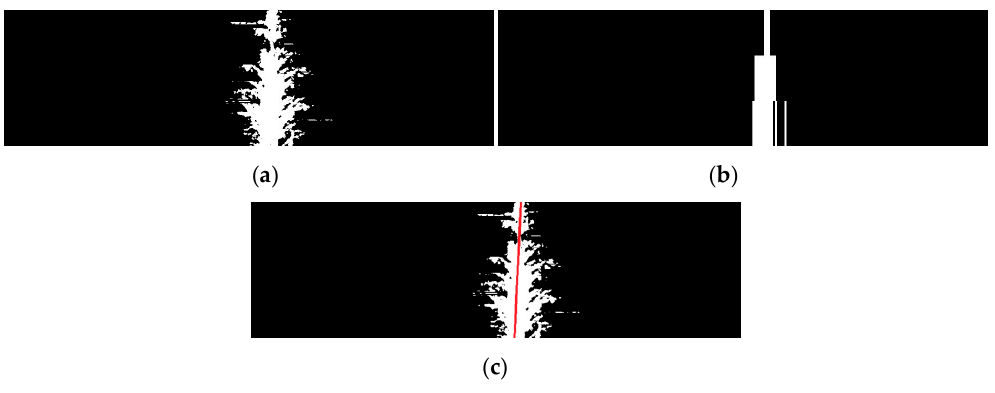
Figure 8. ( a ) Central crop row obtained in the previous stage. ( b ) White and black columns defined by the algorithm from Figure 8a. ( c ) Straight line defining the crop row centre in Figure 8a.